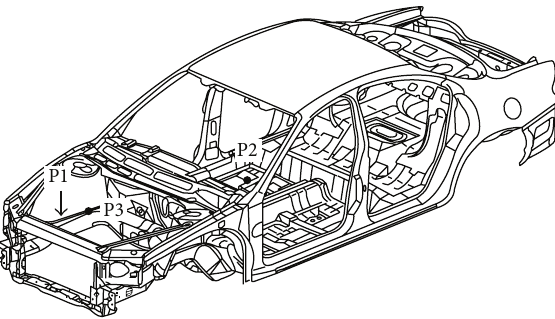
Figure 2: P1: hammer excitation, P2: triaxial accelerometer for body transfer function, and P3: triaxial accelerometer for chassis apparent mass [7].